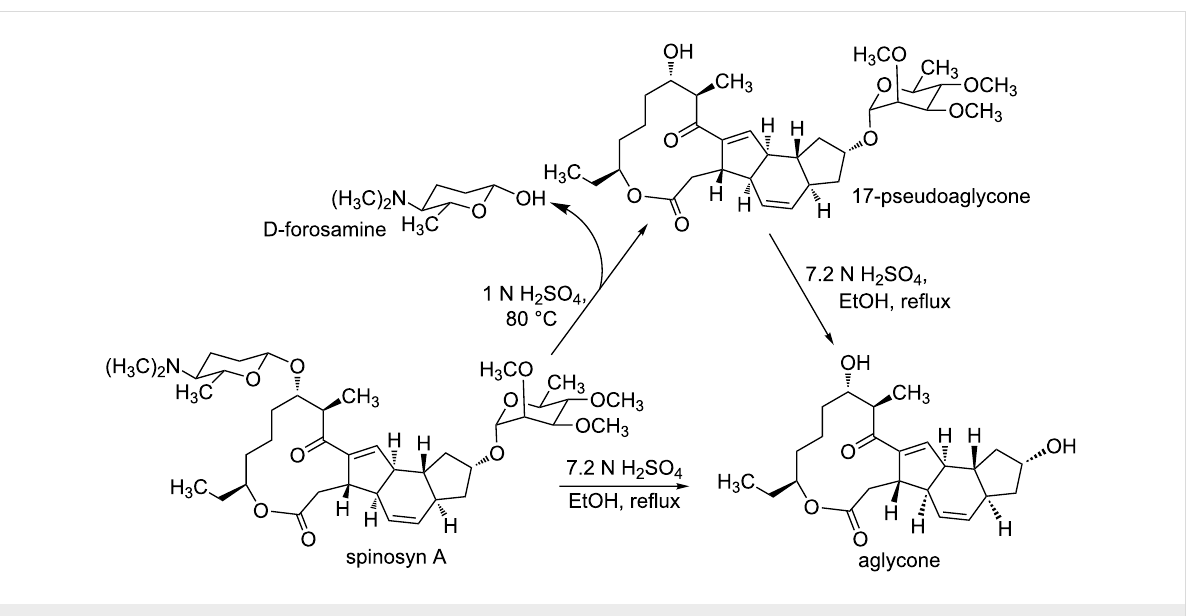
Scheme 3: Hydrolysis of spinosyn A and formation of the aglycone and D